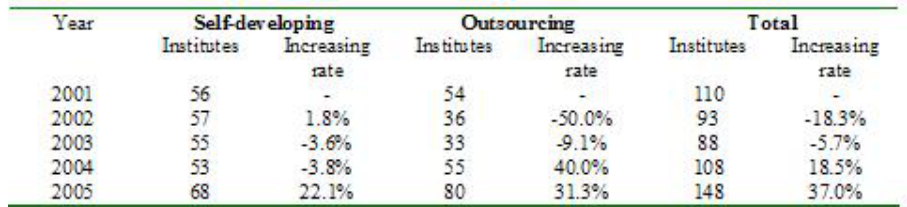
Table 5. Number and Increasing rate of Corporate e-Learning Institutes in Korea (2001-2005)